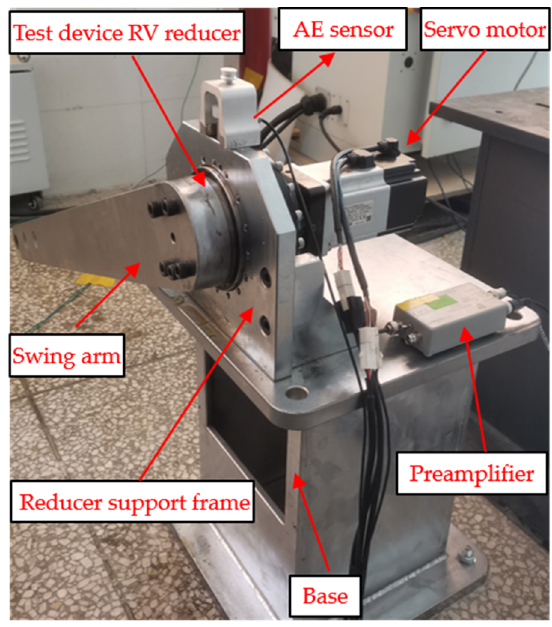
Figure 3. RV reducer failure test bench.